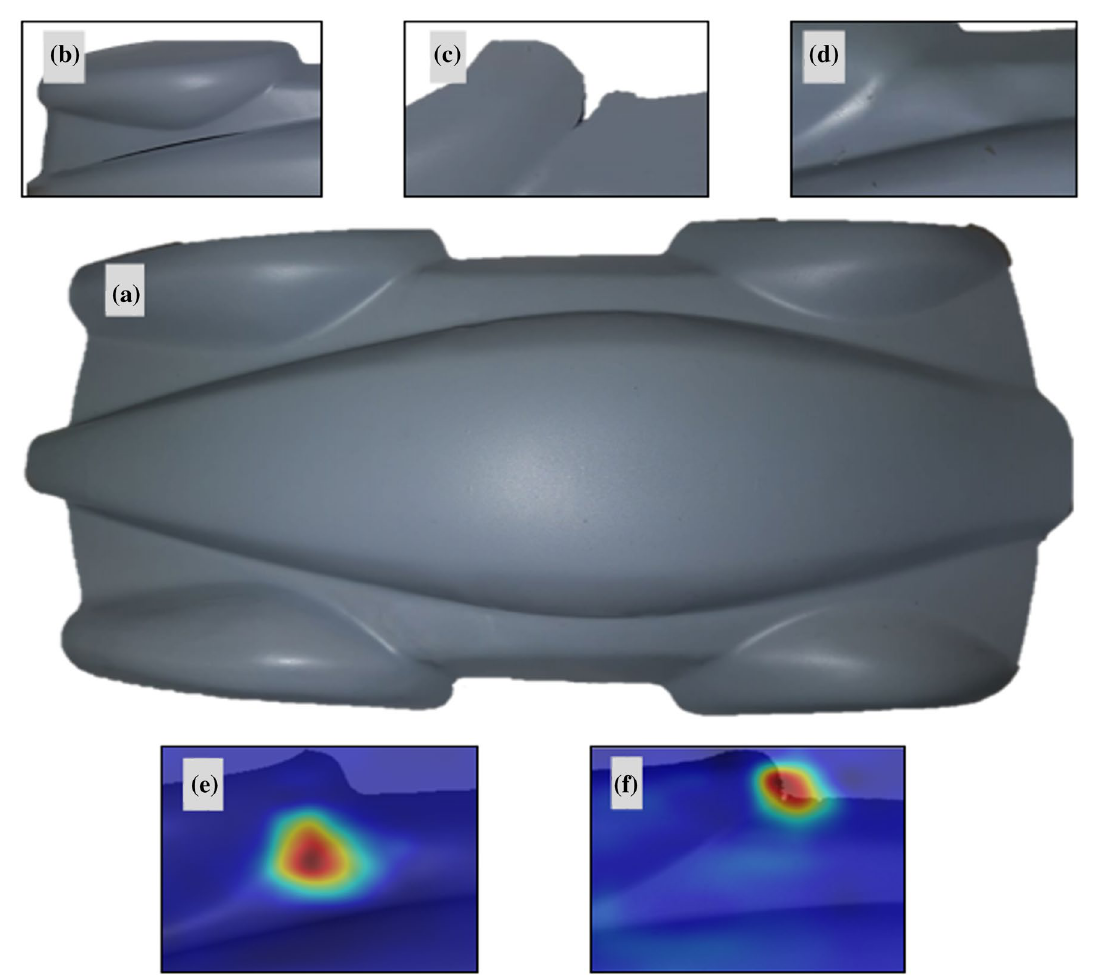
Fig. 8 Formed component; a no defects, b , c crack at different areas, d formation of wrinkling, e heatmap defect formation of wrinkling, f heat map defect crack